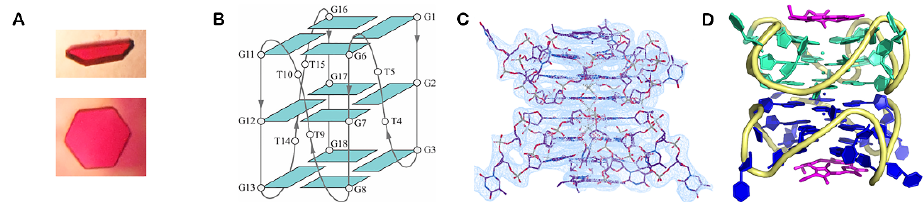
Figure 15. Crystal structure of the T7-NMM complex. ( A ) Representative crystal morphologies: half-hexagonal and hexagonal. ( B ) Schematic representation of the folding topology with the numbering scheme for T1. ( C ) Electron density maps of the T7-NMM dimer. ( D ) Crystal structure of the T7-NMM complex. The T7-NMM sample was prepared by annealing T7 with 1 eq. of NMM at 0.65 mM in 10 mM lithium cacodylate pH 7.2 and 20 mM KCl. Drops were set by the TTP Labtech Mosquito Crystal liquid handler equipped with a humidity chamber at 0.1 μ L DNA sample and 0.1 μ L of the crystallization condition. Small hexagonal crystals grew within three weeks to 80 μ m in the largest dimension from condition C5 of the Natrix screen (Hampton Research): 4.0 M LiCl, 0.01 M MgCl2, and 0.05 M HEPES sodium pH 7.0. Crystals were cryoprotected in the base condition supplemented